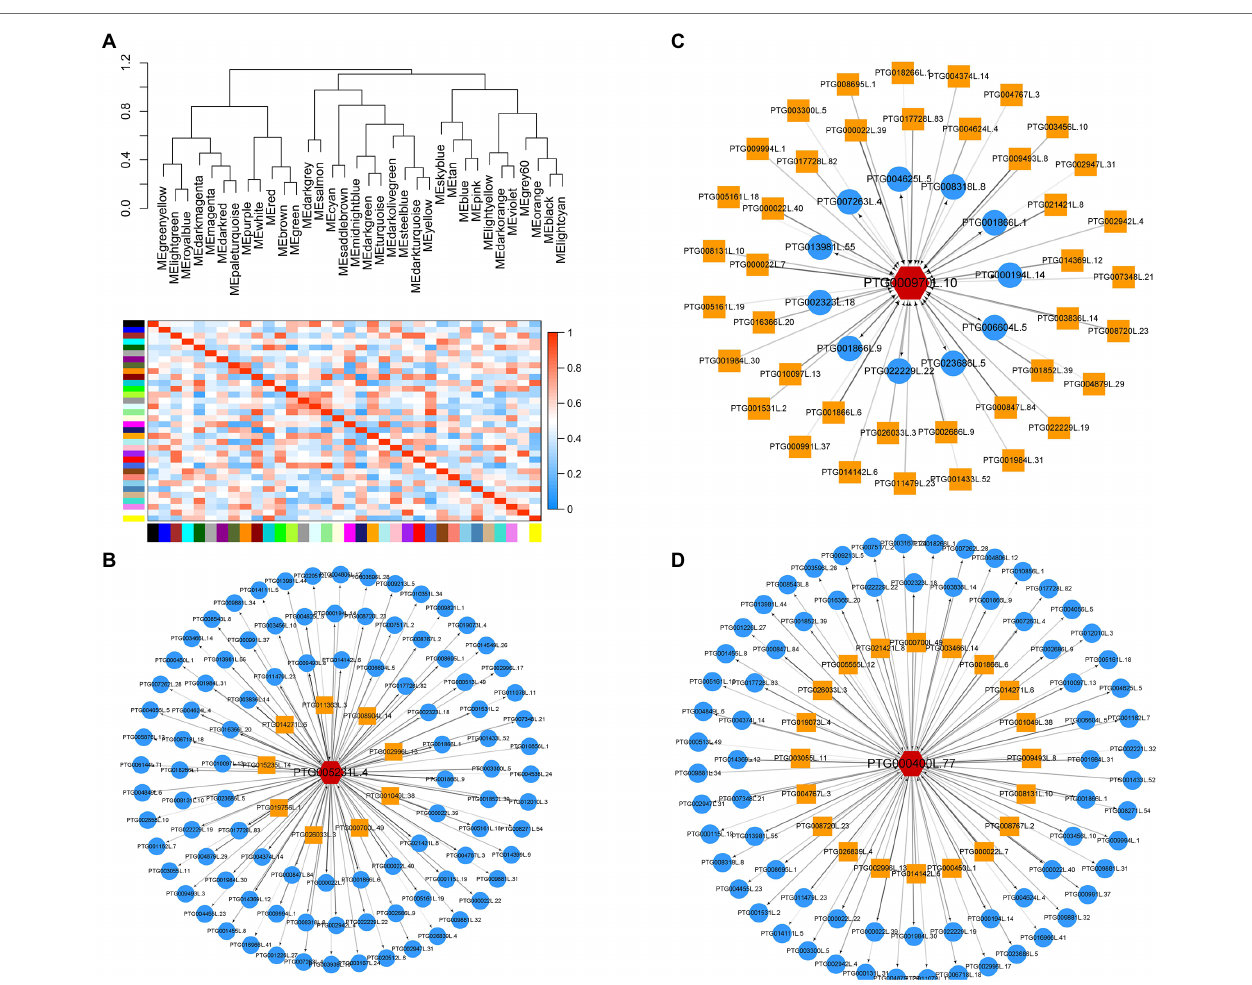
FIGURE 5 | Identification of WGCNA modules associated with nutrient-related transporters under additional N deposition and GR24 treatments. (A) Heat map of the correlation between modules. A total of 35 modules were identified. Cytoscape representation of three nutrient-related transporters including Phosphate transporter 1;4 (evm.TU.PTG005231L.4) (B) , High affinity sulfate transporter 2(evm.TU.PTG000970L.10) (C) zinc ABC transporter ATPase(evm.TU.PTG000400L.77) (D) . The yellow box represents the upstream of the target gene, and the blue circle represents the